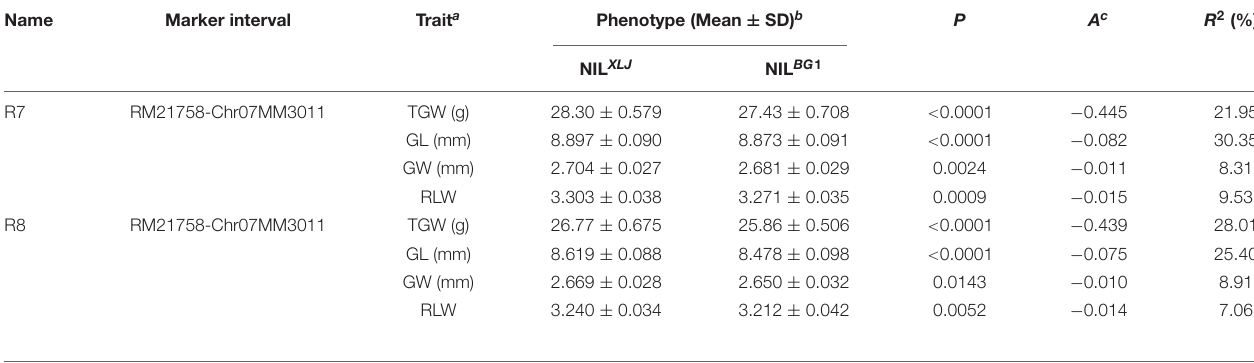
TABLE 1 | Validation of qGS7.1 using two residual heterozygous populations in BC 4 F 7 .